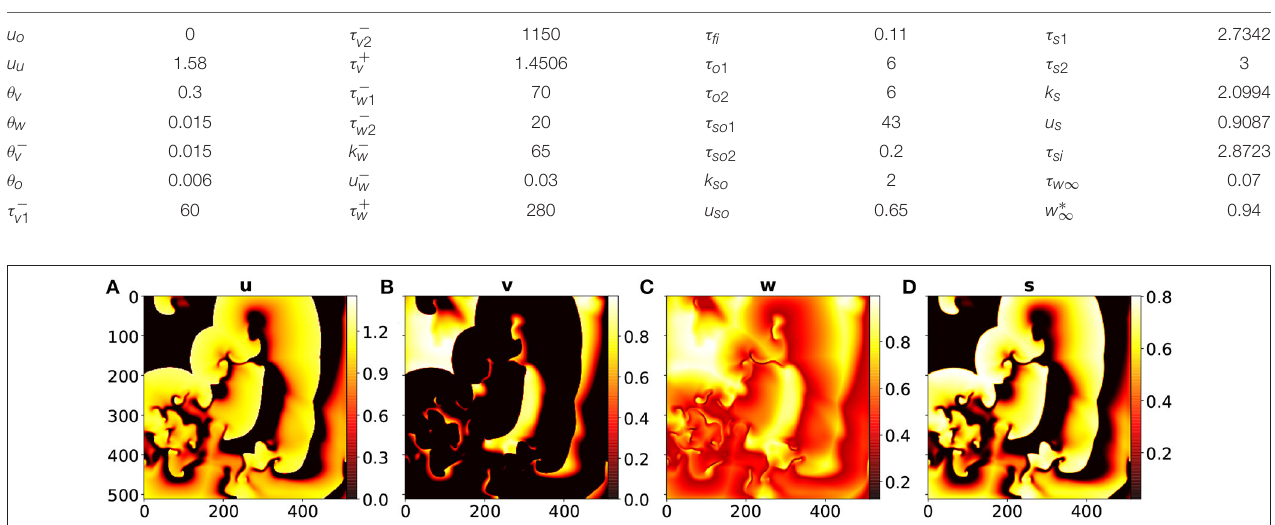
FIGURE 2 | Snapshots from the BOCF model at t = 100 of (A) the u variable, (B) the v variable, (C) the w variable, and (D) the s